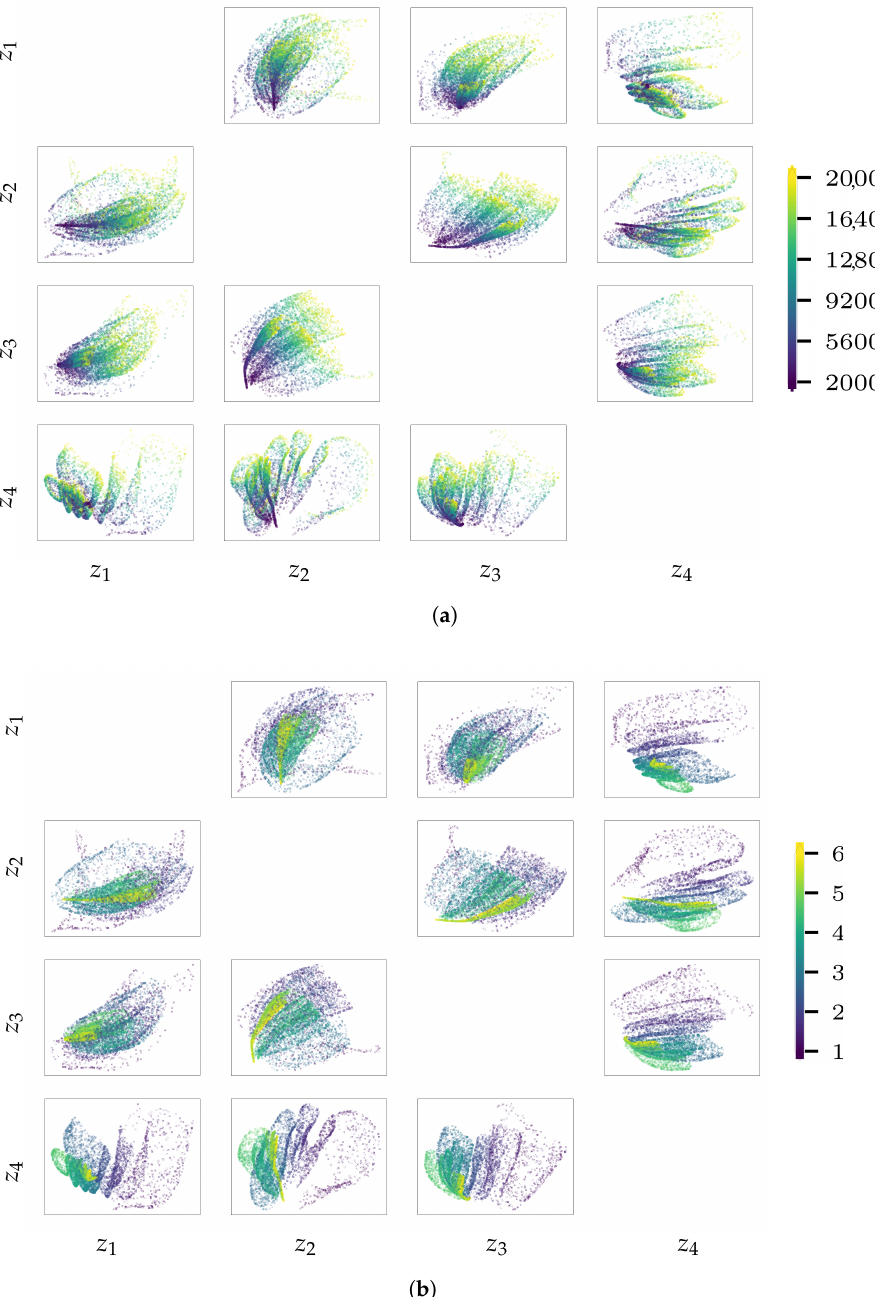
Figure 25. Pirelli Tower, load case 1. Scattered latent representation z determined by enc for the validation set, with coding set by ( a ) the load amplitude α or by ( b ) the load frequency φ